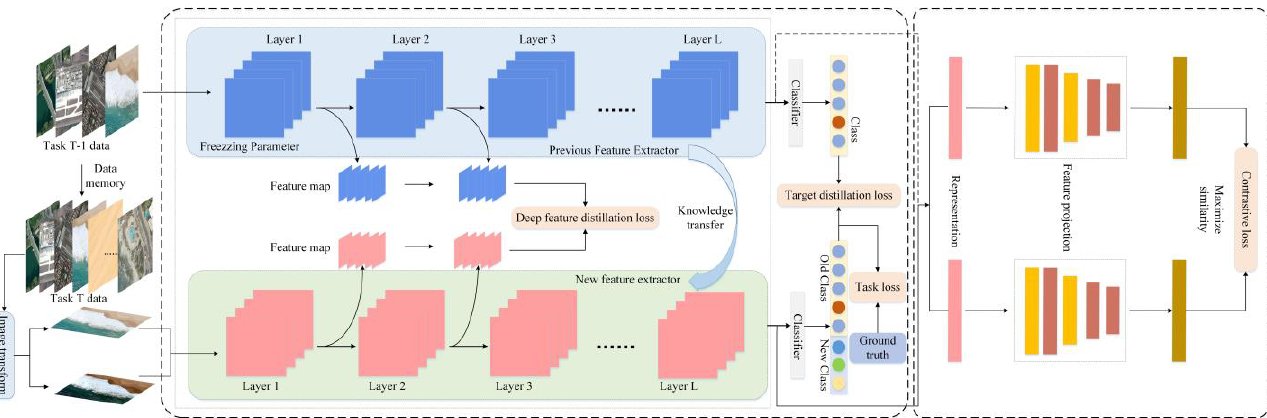
Figure 1. Overview of our proposed